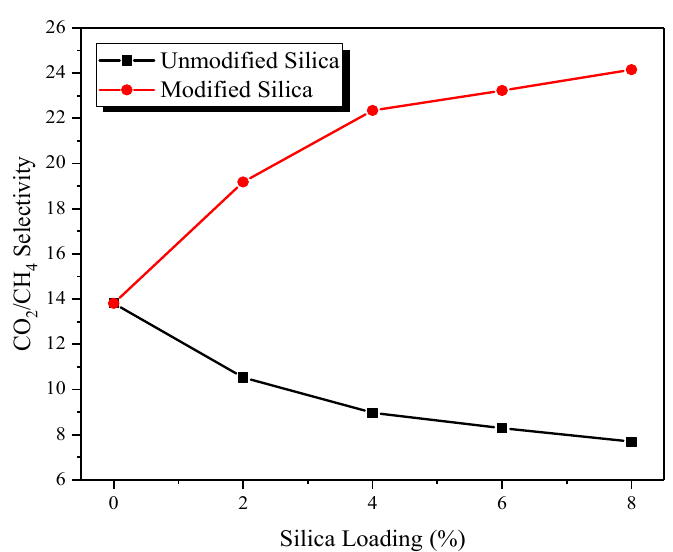
Figure 8. Effect of modified silica loading on ideal selectivity of MMMs.